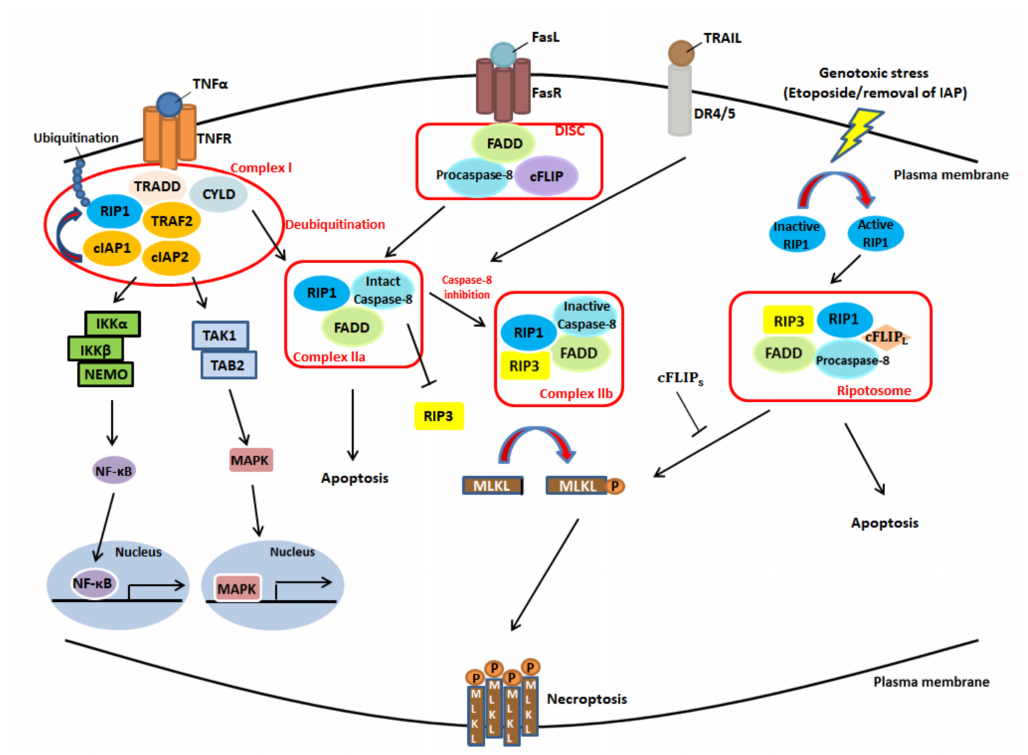
Figure 2. Overview of the cell death receptor-associated signaling pathway. The signaling